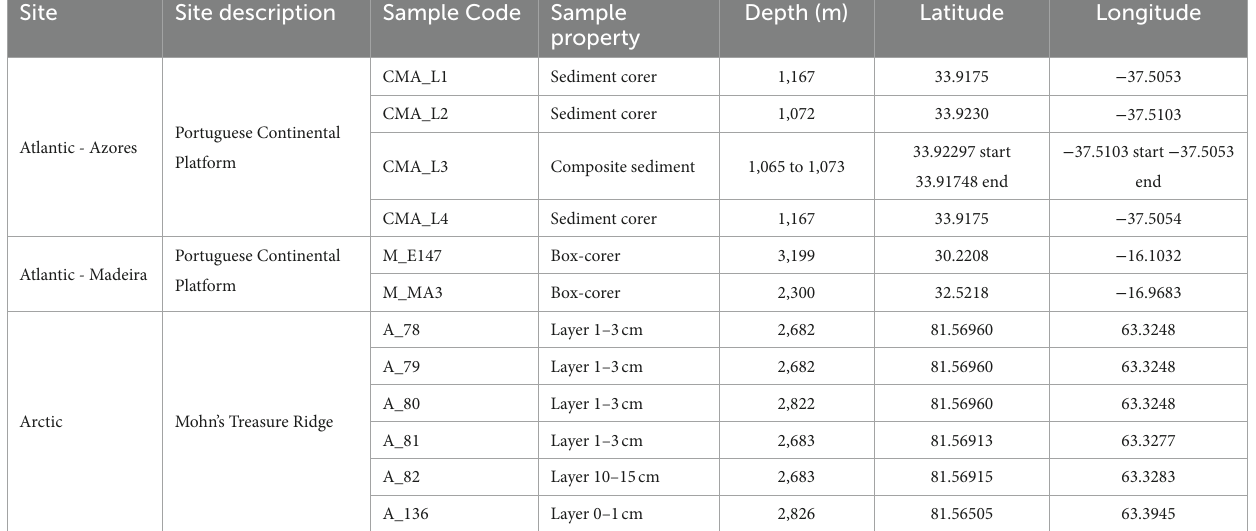
TABLE 1 Site description of the deep-sea sediment samples used in this